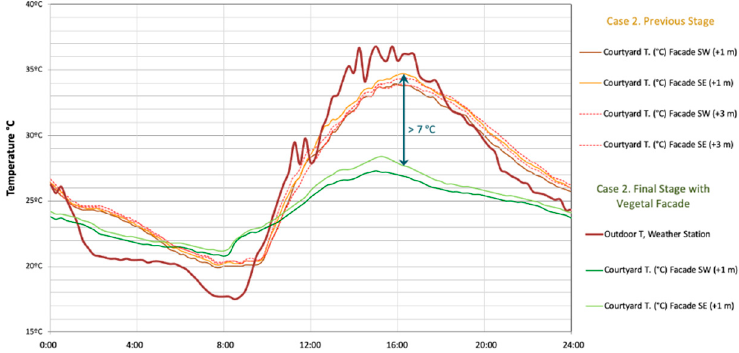
Figure 16. Case study 2: comparison of thermal behavior pre and post vegetal facade installation.